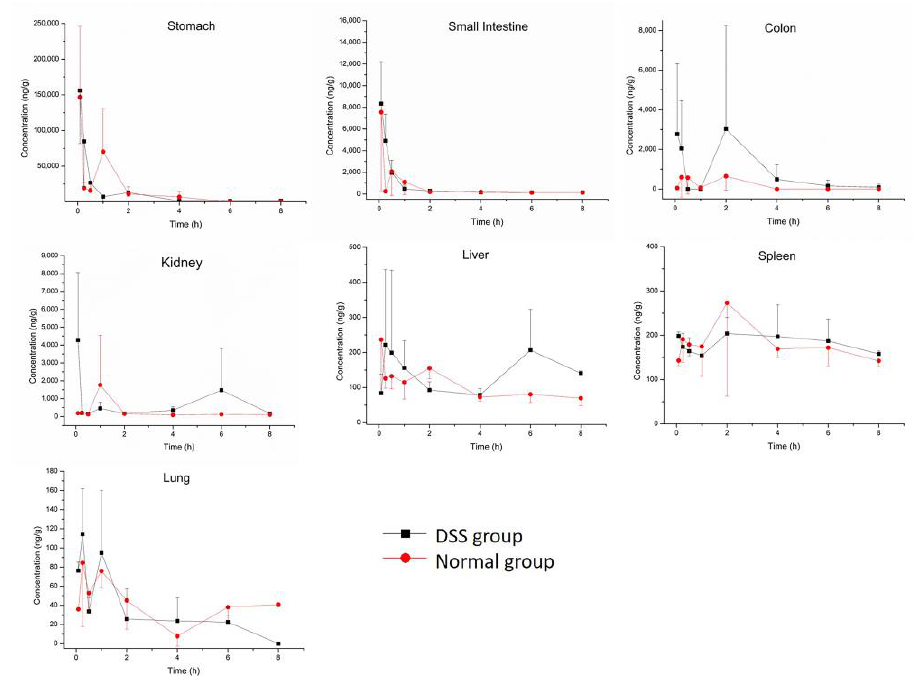
Figure 2. Tissue distribution profiles of M10 in DSS-group mice and normal-group mice. Data are expressed as mean ± SD (n = 3). The mice were orally administered 50 mg/kg of M10 and terminated after 5 min, 15 min, 30 min, 1 h, 2 h, 4 h, 6 h and 8 h in order to collect tissues.